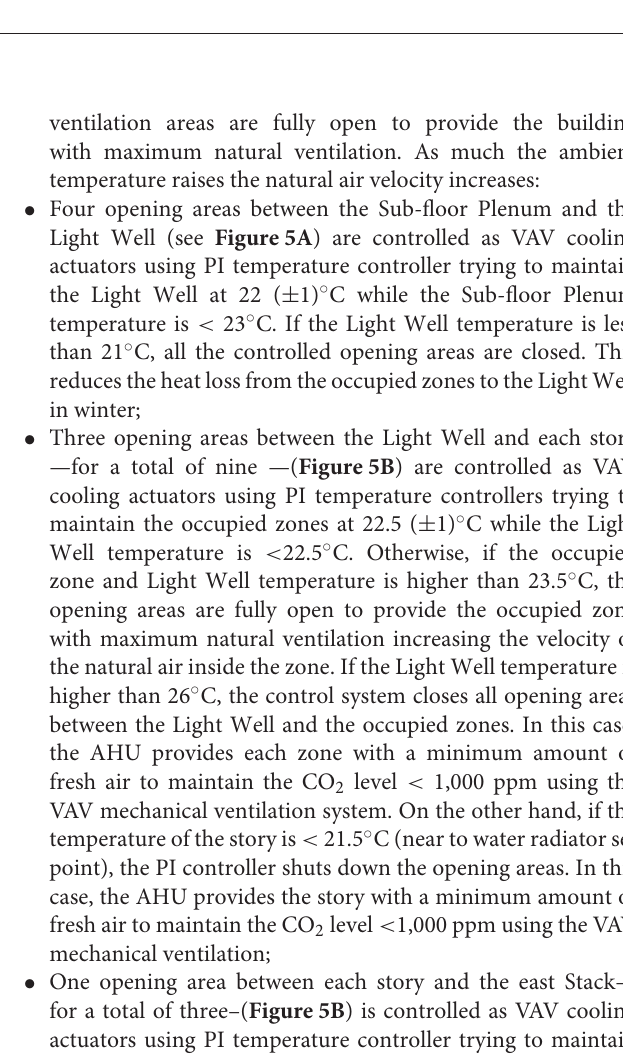
FIGURE 5 | Hybrid 2. (A) Sub-floor Plenum—plan. (B) Typical story—plan.